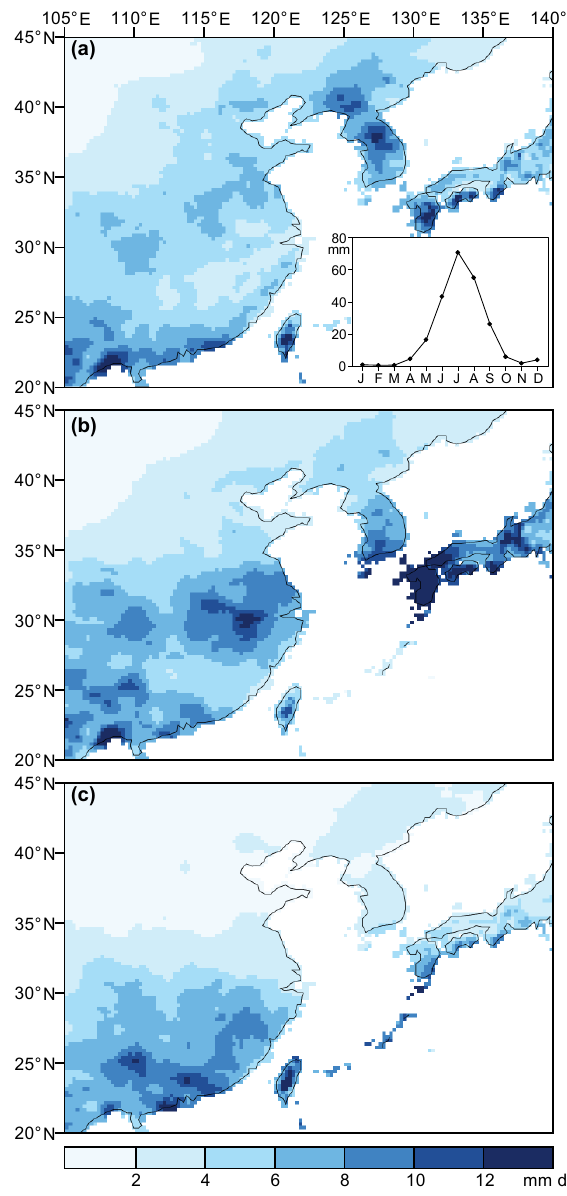
Figure 4. A sketch map of eastern China, Korea, and western Japan showing precipitation rates of the current East Asian summer mon- soon. Data are averaged by observations of the years 1979–2007 and expressed in mmd − 1 at a grid resolution of 0 . 25 ◦ × 0 . 25 ◦ . (a) The 4th, 5th, and 6th pentads of July and the 1st pentad of August. (b) The 5th and 6th pentads of June and the 1st and 2nd pentads of July. (c) The 5th and 6th pentads of May and the 1st and 2nd pentads of June. The inset in Fig. 4a shows monthly changes in an- nual precipitation in the Hulun Lake region (data from observations of the years 1976–2005).